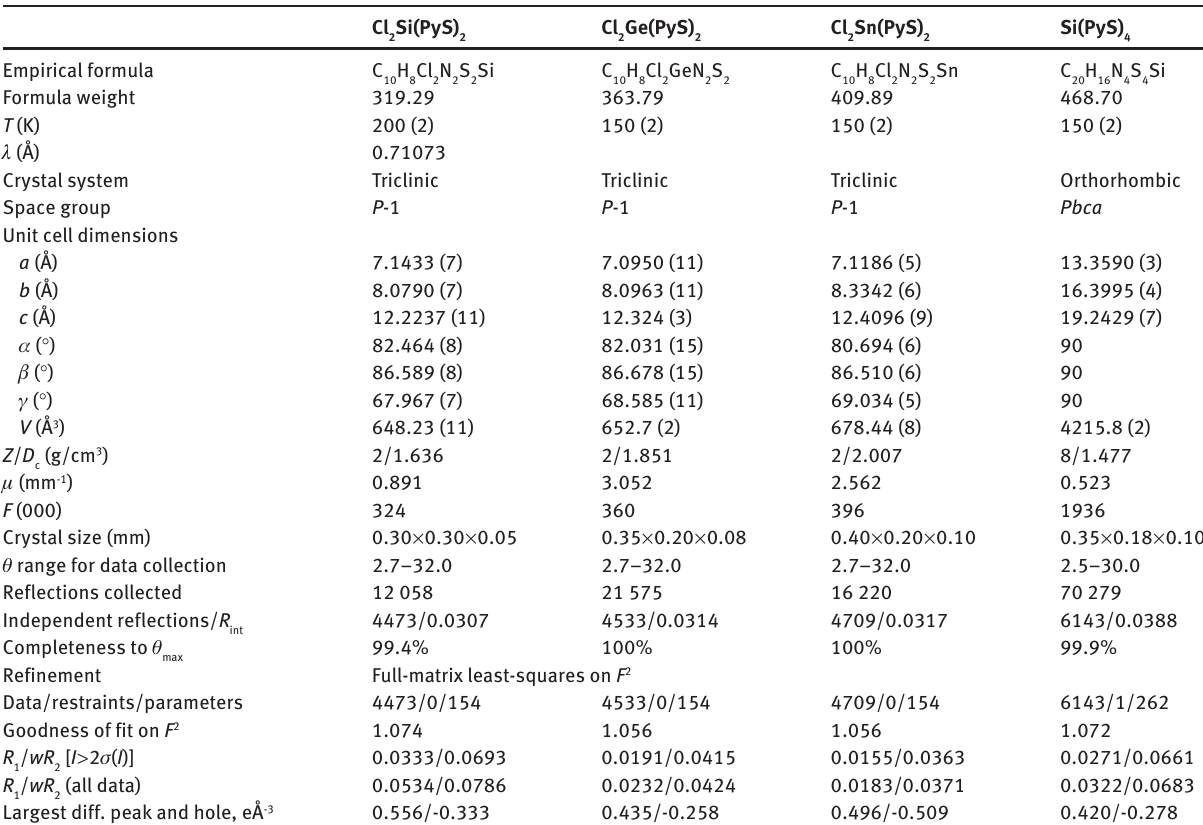
Table 1 Crystallographic parameters of data collection and structure refinement for the crystal structures of Cl Cl Sn(PyS) , and Si(PyS) 2 2